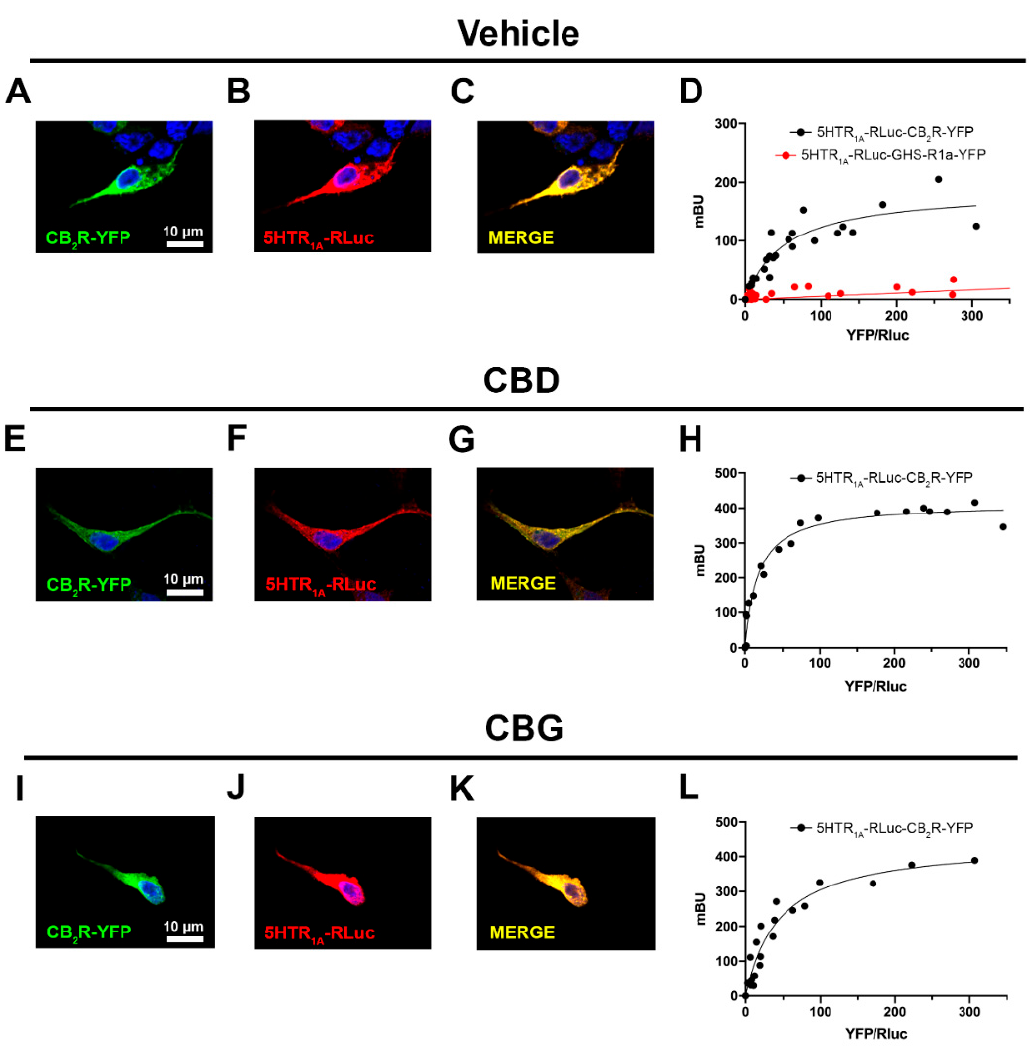
Figure 1. Effect of CBD or CBG on the 5HT 1A R–CB 2 R interaction. ( A – C , E – G , I – K ) Confocal micro- scope images of HEK-293T cells expressing CB 2 R-YFP (0.75 μ g cDNA) and 5HT 1A R-RLuc (0.5 μ g cDNA). Cells were pretreated with 200 μ M of CBD ( A – C ), 200 μ M of CBG ( E – G ), or vehicle ( I – K ) for 30 min. 5HT 1A R-RLuc (red) was identified by immunocytochemistry using an anti-RLuc anti- body. The CB 2 R-YFP (green) was identified by its own fluorescence. Co-localization is shown in yellow. Cell nuclei were stained with Hoechst (blue). Scale bar: 10 μ m. ( D , H , L ) Bioluminescence resonance energy transfer (BRET) assays performed in HEK-293T cells co-transfected with a con- stant amount of cDNA for 5HT 1A R-RLuc (1.5 μ g) and increasing amounts of cDNA for CB 2 R-YFP (0.2 to 4 μ g) or, as negative control, with a constant amount of cDNA for 5HT 1A R-RLuc (0.75 μ g) and increasing amounts of cDNA for GHSR-1a-YFP (0.2 to 2 μ g cDNA). Transfected cells were pre- treated with 200 nM of CBD ( D ), 200 nM of CBG ( H ), or vehicle ( L ) for 30 min before fluorescence emission was recorded. BRET data are expressed as the mean ± S.E.M of 8 different experiments performed in duplicates. mBU: milliBret units.